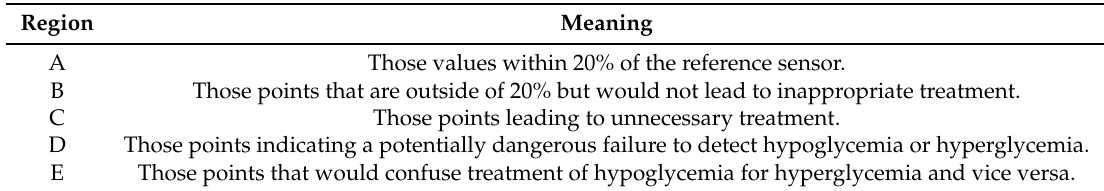
Table 4. The meaning of each region in Clarke Error